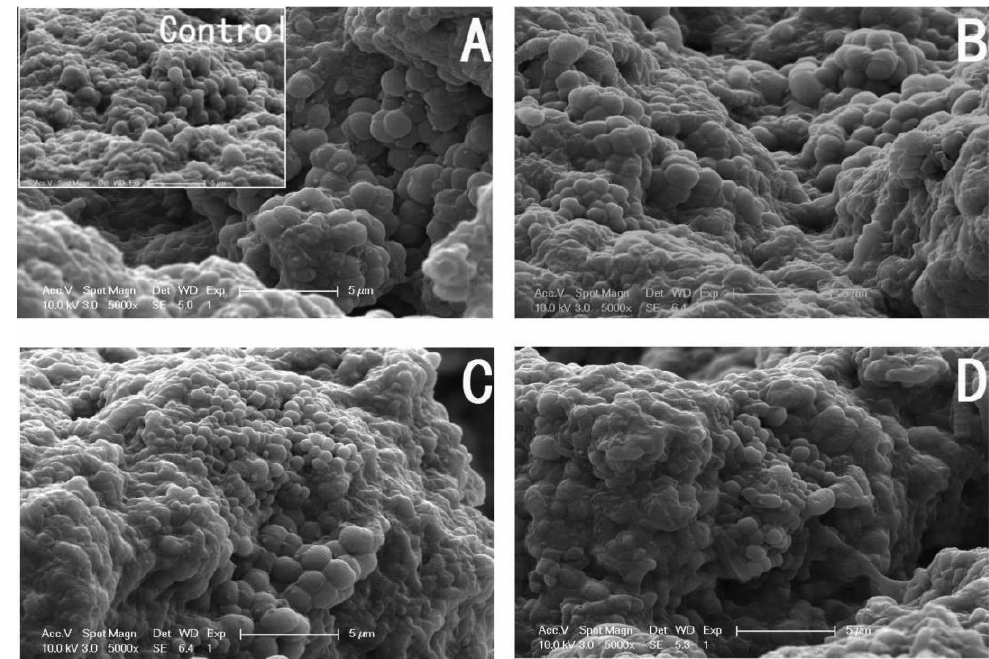
Figure 9. SEM images showing activated sludge exposed to different concentrations (0.1 mg/L ( A ), 1 mg/L ( B ), 5 mg/L ( C ) and 10 ( D ) mg/L) of CuNPs [119]. The surfaces of the cells did not seem to be damaged by the concentrations investigated. However, the toxic effects of CuNPs (at higher con- centrations) are illustrated in another study by the authors [118].